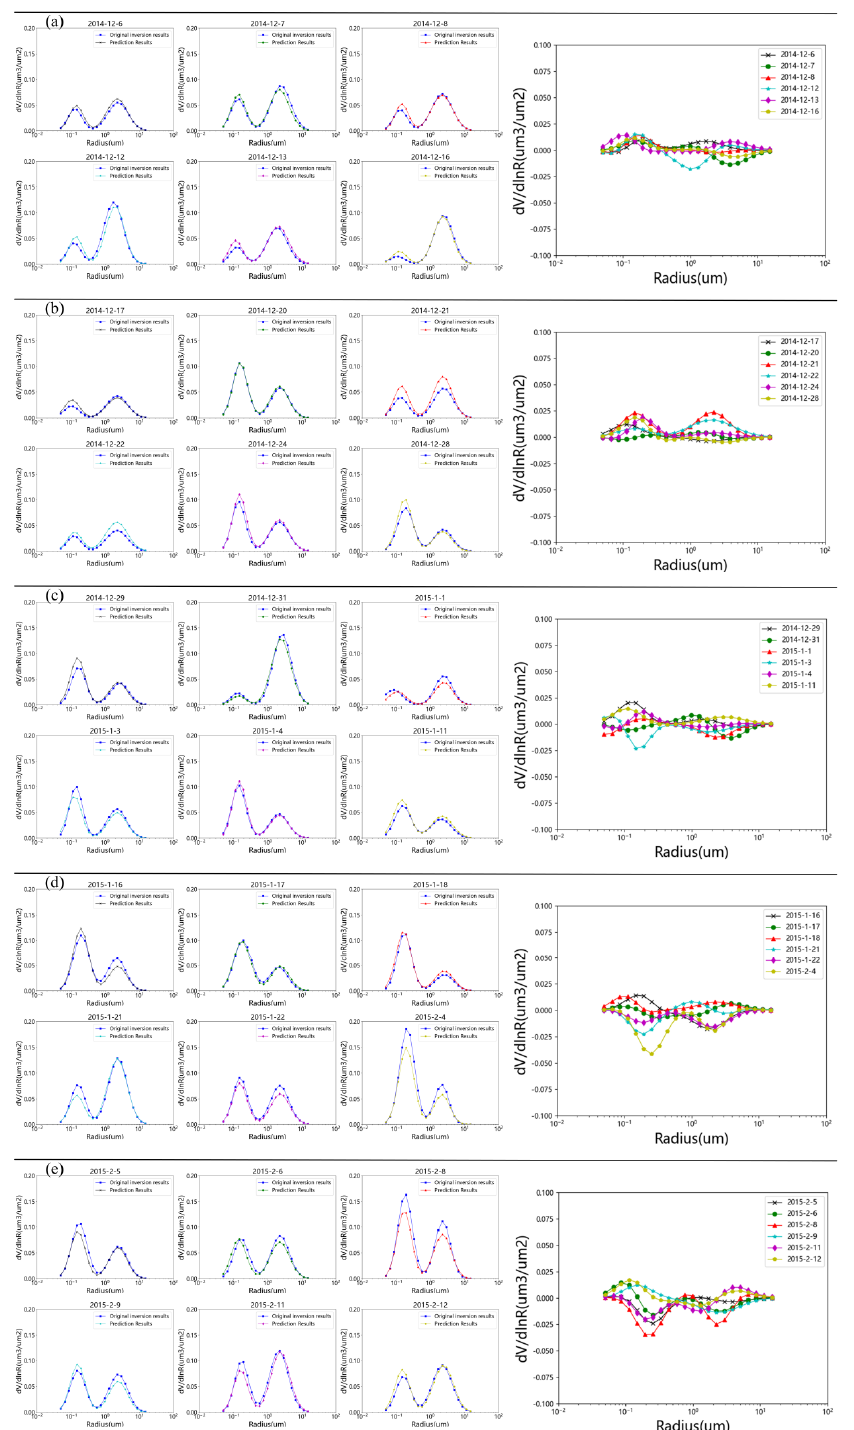
Figure 6. The six figures on the left in ( a ) show the comparison of the inversion results for the first six days of the 30-day period, where the blue lines with squares are the original inversion result of